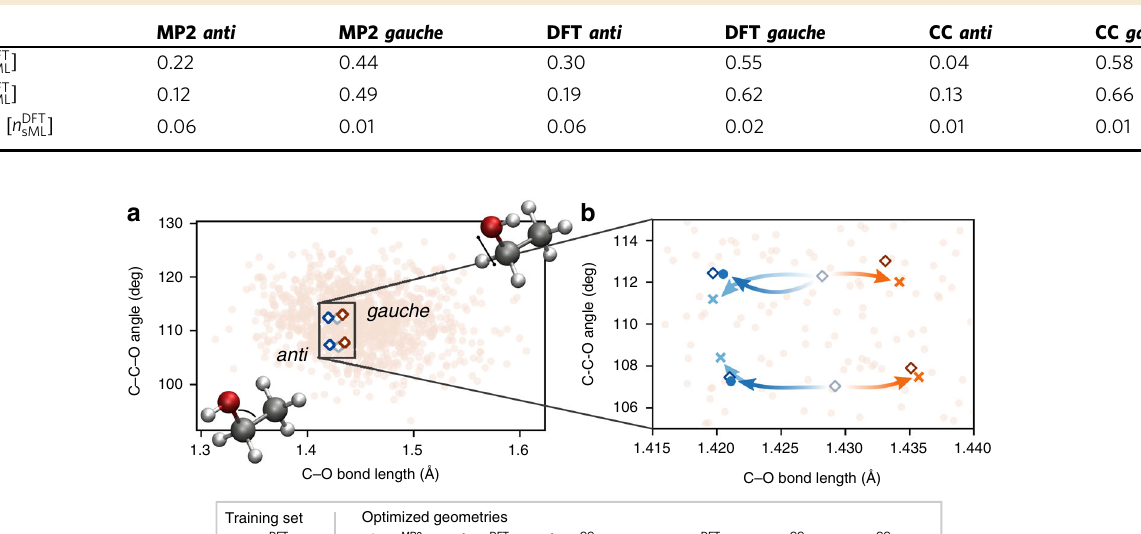
Table 2 Energy errors (kcal mol − 1 ) of the sML-HK maps for ethanol at conventionally optimized geometries.